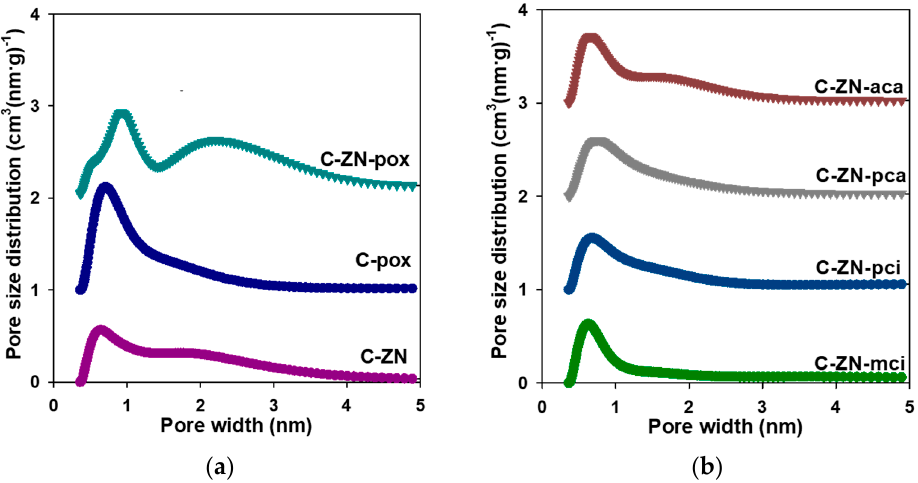
Figure 3. ( a ) Pore size distributions determined for C-ZN, C-pox and C-ZN-pox; ( b ) pore size distributions determined for C-ZN-aca, Z-CN-pca, C-ZN-pci and C-ZN-mci. For clarity the y -axis for each subsequent pore size distribution (PSD) curve was shifted upward by 1 cm 3 ·(g·nm) − 1 .